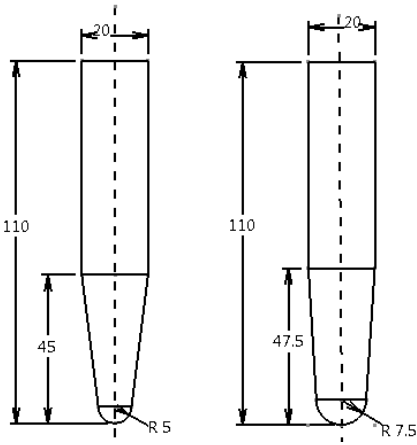
Figure 5. The hemispherical-end forming tools (all dimensions in mm).